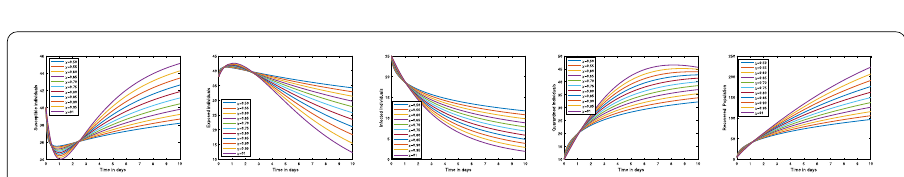
Figure 1 For χ = 0.8, plots of S , E , I , Q , R